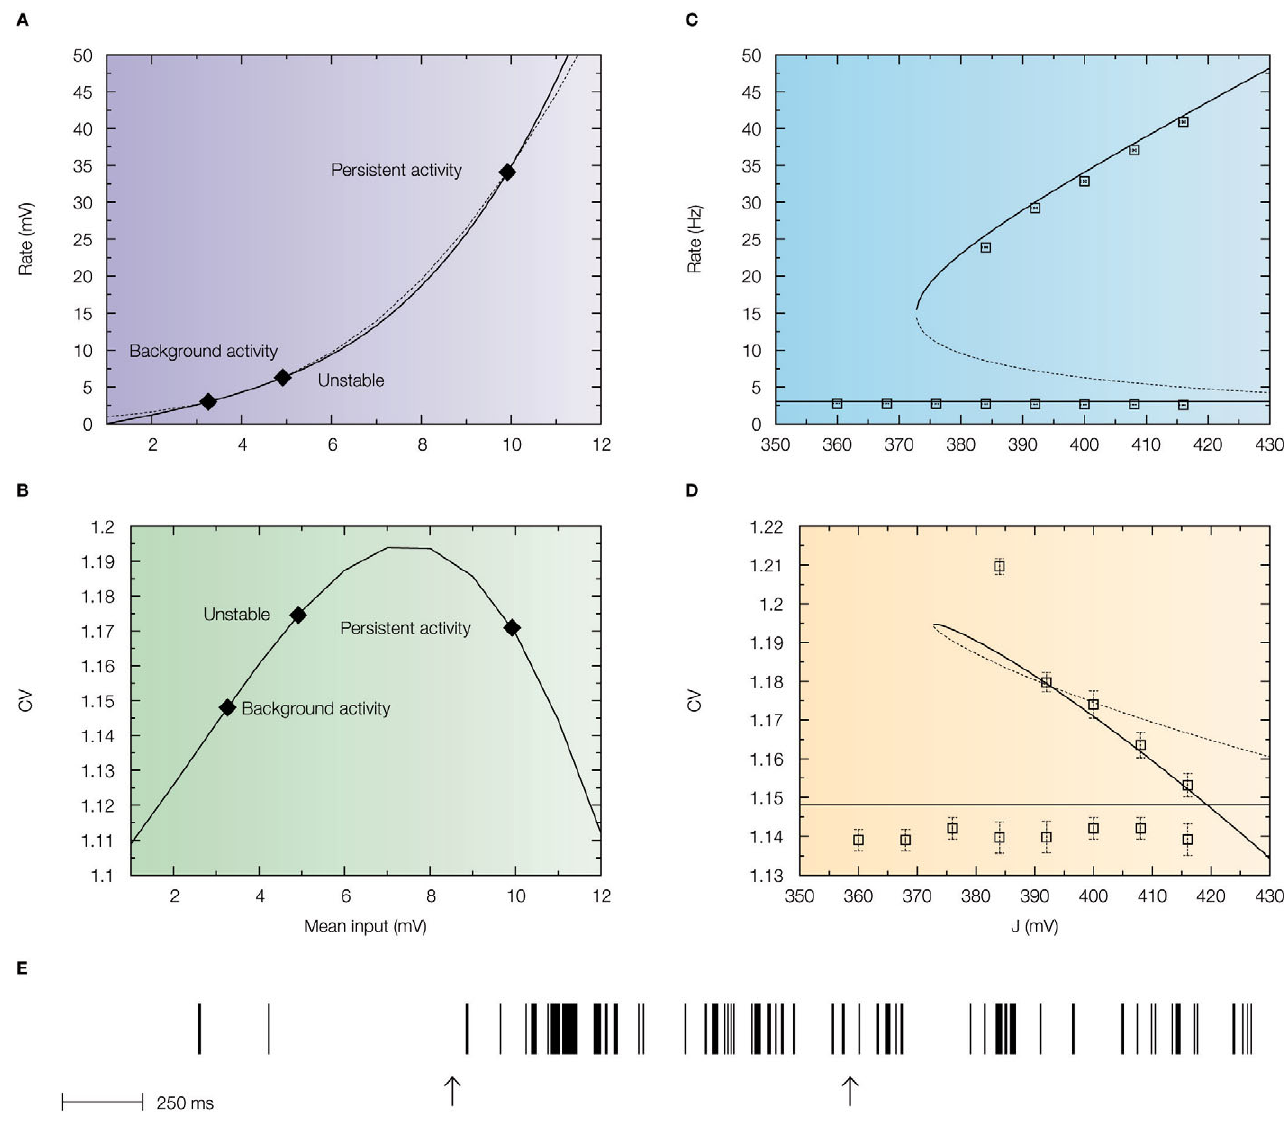
Figure 5 | An excitatory network with high reset potentials of individual neurons and short-term depression of excitatory synapses produce highly irregu- lar persistent activity. Mean fi ring rate and CV of a population of excitatory leaky integrate-and-fi re neurons with high reset (5 mV below threshold) connected by excitatory synapses with short-term depression (see Barbieri and Brunel, 2007 for more details). (A) f-I curve (solid line) plotted together with the current-rate relationship for synapses with short-term depression (dotted curve). Intersections between these two curves (diamonds) yield the solutions of the mean-fi eld equa- tion. They correspond to background, unstable and persistent fi xed points, respectively. (B) CV-I curve. Diamonds: Values of the CV for the three intersection points shown in (A) . (C) Bifurcation diagram showing fi ring rate vs. J . The black curve correspond to the persistent state (stable), the dotted one to the boundary of the basin of attraction (unstable) and the horizontal one to the background state (stable). (mean-fi eld: lines; simulations: symbols). (D) CV vs. J bifurcation diagram. There exists a fi nite range of values of the synaptic effi cacy for which the CV in the persistent state is larger than in the background one (370 mV < J < 420 mV in the fi gure). Mean-fi eld: lines; simulations: symbols. (E) Spike train of one cell in a simulated network of 1000 neurons; arrows indicate beginning and end of the stimulus presentation. Note the high irregularity of this spike train during the delay period, contrary to the one shown in Figure